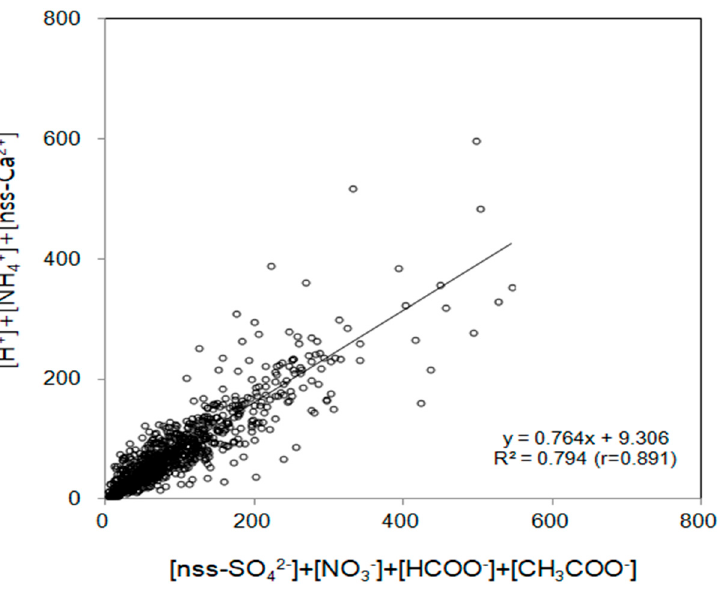
Figure 7. Correlation between ∑ ([H + ] + [NH 4+ ] + [nss-Ca 2+ ]) and ∑ ([nss-SO 42 − ] + [NO 3- ] + [HCOO − ] + [CH 3 COO − ]).